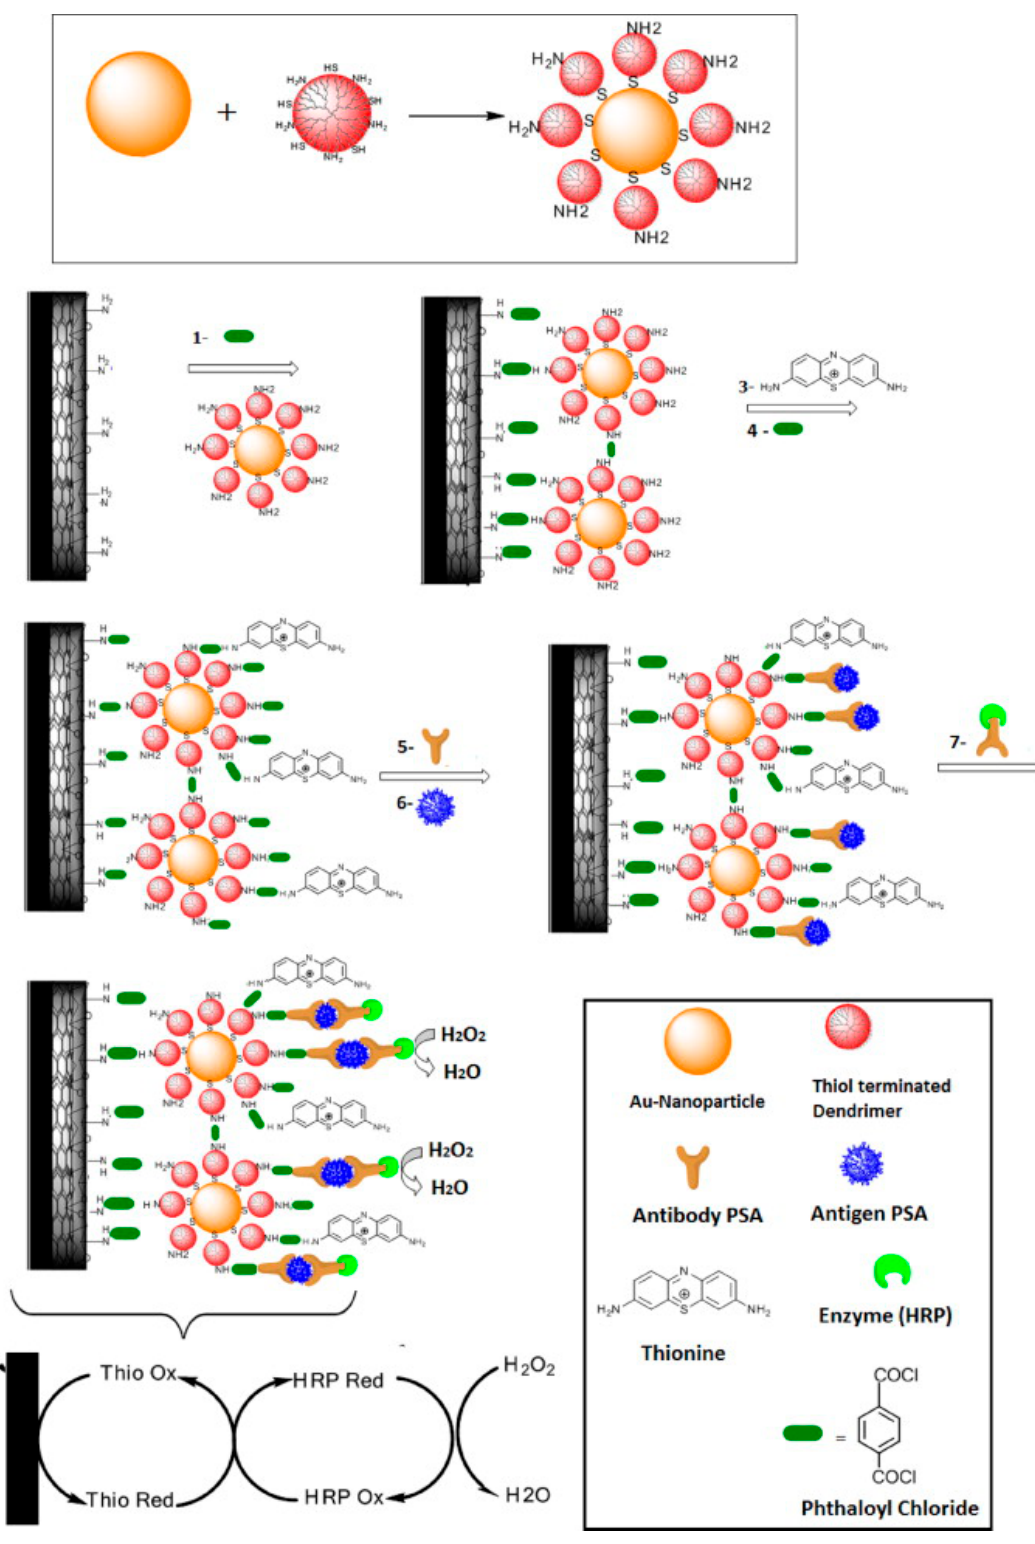
Figure 2. Illustration of the stepwise process for PSA immunosensor fabrication. Briefly, to prepare sensor electrode, physical mixture of MWCNTs and IL was coated onto GCE which was then modified with PAMAM decorated gold nanoparticles via phthaloyl chloride chemistry. Phthaloyl chloride chemistry was further utilized for thionine and anti-PSA immobilization. Reproduced with permission from [42].